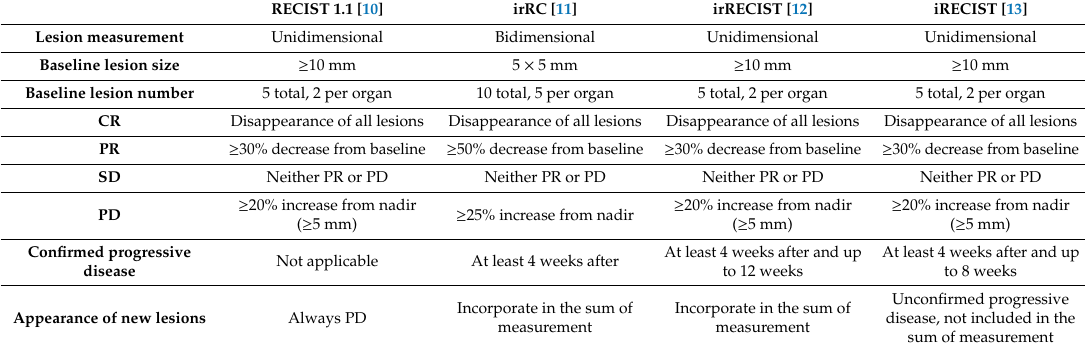
Table 2. Overview of immune-specific related response criteria reported in the